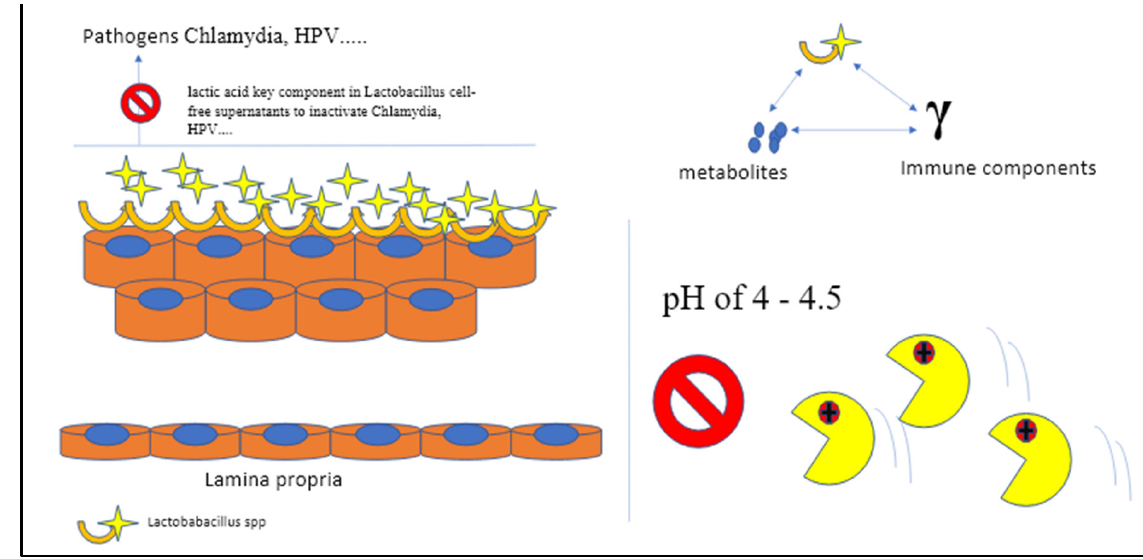
Figure 3. The bacteria that make up the vaginal microbiome are inextricably linked to the acidity of the vaginal environment. The local flora is crucial for the local microbiome homeostasis, and the whole chain of bioreaction takes place in spaces with a specific mean pH of 4–4.5. A vagina with a pH of 4.5 or below defends against harmful pathogens that are unable to survive in such an acidic environment (C Gargiulo Isacco, K CD Nguyen).